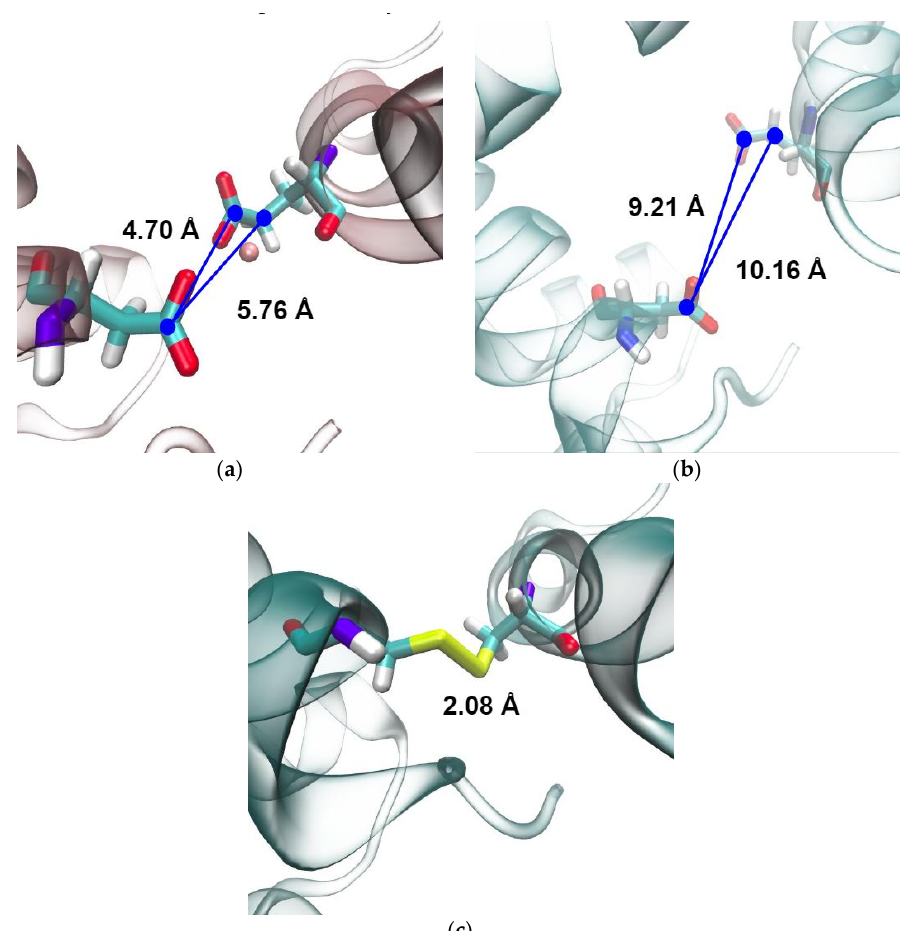
Figure 5. The second binding site of B. subtilis MntR. ( a ) The Mn 2+ ion in the second binding site is coordinated by residues Asp8 and Glu99. ( b ) The distance between Asp8 and Glu99 at the end of the simulation of the apo system. ( c ) The cysteine bridge between residues Cys8 and Cys99 was constructed to imitate the binding of the Mn 2+ ion in the second binding